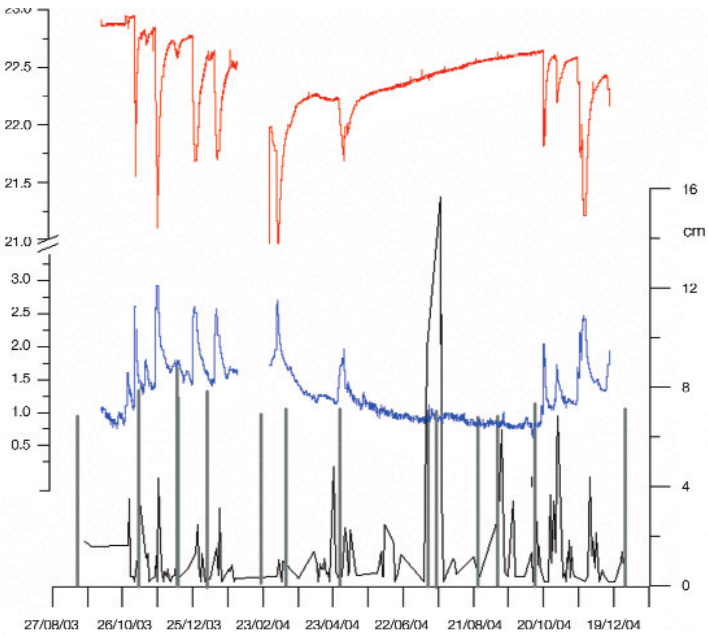
Fig. 11. Temporal variations in water temperature (21-23°C) and water level (0.5-3 m) in the Puzzola spring from August 2003 to February 2005. The earthquakes that occurred within a 20 km-radius area centered on Por- retta Terme town are shown as vertical grey lines. The rainfalls are reported as daily mean value for the entire monitoring period (0-16 cm). The rain-gauge is located close to the Porretta thermal